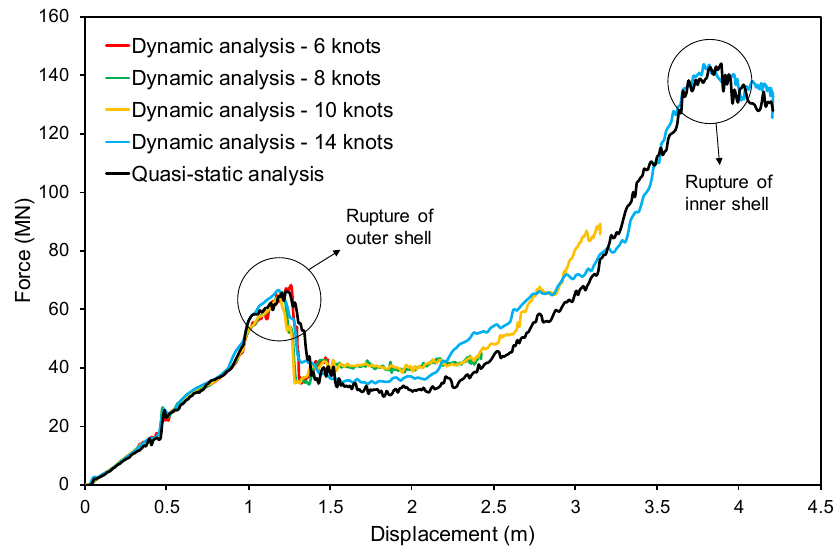
Figure 9. Force–displacement curves obtained for different speeds and analysis models. The energy absorption capacity of the struck structure and the extent of structural damage are essential in ship collision analysis. Figure 10 presents the deformation stages of the outer shell predicted by dynamic (14 knots) and quasi-static analyses. The snapshots in Figure 10 show bulb penetration and illustrate the rupture process of the outer shell. The sub-figures on the top-left correspond to the first peak observed in the force–displacement curve. The other sub-figures correspond to the instants associated with the decrease in force after the first peak. The contours show the necking indicator. The rupture mechanism of the outer (and inner) side panel, subjected to biaxial pre-dominantly membrane stretching, is localized necking preceding fracture. The location of fracture initiation and propagation of the crack predicted with the rate-dependent and -independent DSSE models were similar. In addition, the adopted mesh size was fine enough for modeling the collision footprint of the striking bulbous bow accurately. The damage extent was significant for residual strength assessments of the ship hull girder using simplified